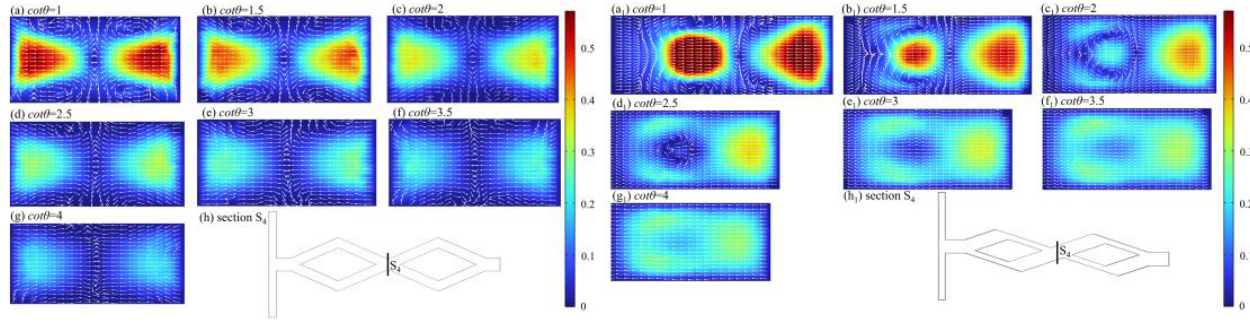
Figure 12. Velocity distribution (m/s) and vector of S 4 section at Re = 60 under different cot θ. ( a – g ) Symmetric rhombus micromixer; ( h ) Section S 4 ; ( a 1 – g 1 ) Asymmetric rhombus micromixer; ( h 1 ) Section S 4.